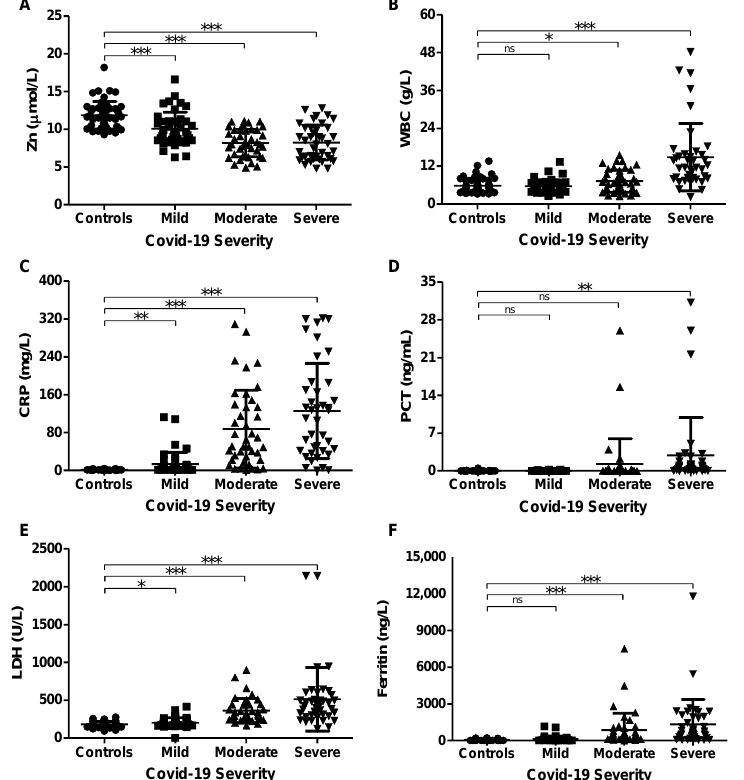
Figure 1. Serum zinc and inflammatory marker levels in controls and COVID-19 patients. Blood from controls ( n = 48), mild ( n = 42), moderate ( n = 41), and severe ( n = 40) COVID-19 subjects was used to assess zinc ( A ), WBC ( B ), CRP ( C ), PCT ( D ), LDH ( E ), and ferritin ( F ) levels. Values are plotted as replicates (mean ± SD). * p < 0.05, ** p < 0.01, and *** p < 0.001. ns, not significant.